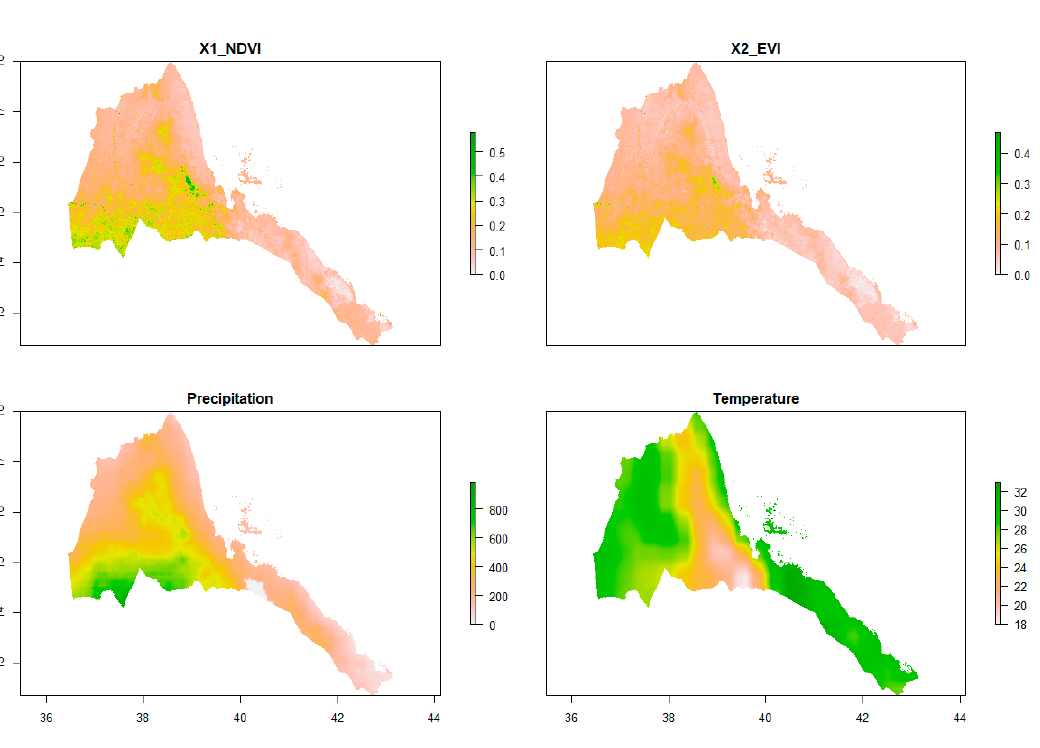
Figure 4 . Mean annual NDVI, EVI, temperature, and total precipitation during 2000 –